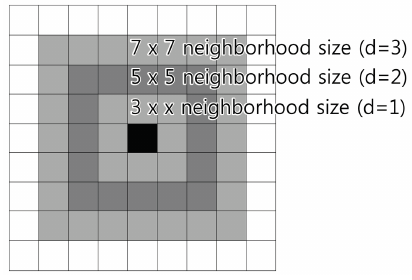
Figure 3. Configuration of neighborhood size (advised from Verburg et al. [21] ).